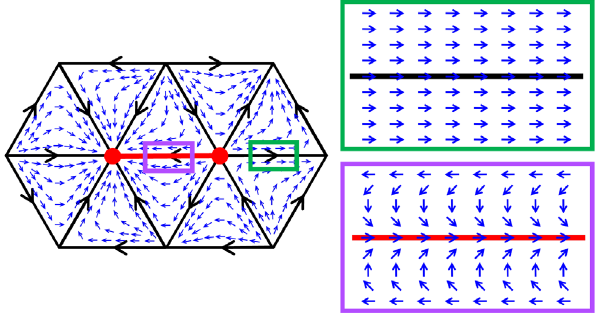
FIG. 10. The red vertices mark singularities of the interpolating vector field with odd winding numbers, and the red link gives a choice of E . The green inset shows the interpolating vector field near a link not belonging to E , while the purple inset shows the 2 π twist of the vector field near a link in E